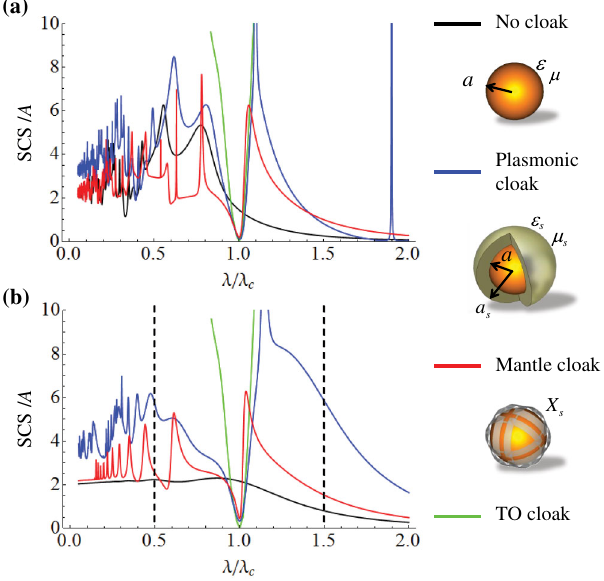
FIG. 1. Normalized scattering cross section over a broad range of wavelengths for different cloaking techniques: the normaliza- tion factor A is the geometrical cross section of the uncloaked sphere. The cloaks are designed to suppress the scattering of (a) a dielectric sphere with " ¼ 5 and diameter 2 a ¼ 100 nm and (b) a PEC sphere of the same size, at the central wavelength ¼ 300 nm . In both panels, the scattering spectrum of the (cid:1) c uncloaked objects (black curves) is compared to the response of different cloaking designs: the plasmonic cloak (blue curves), the mantle cloak (red curves), and the transformation-optics cloak (green curves). The vertical dashed lines in (b) enclose the bandwidth considered for the time-domain animations in Figs. 2(c) and